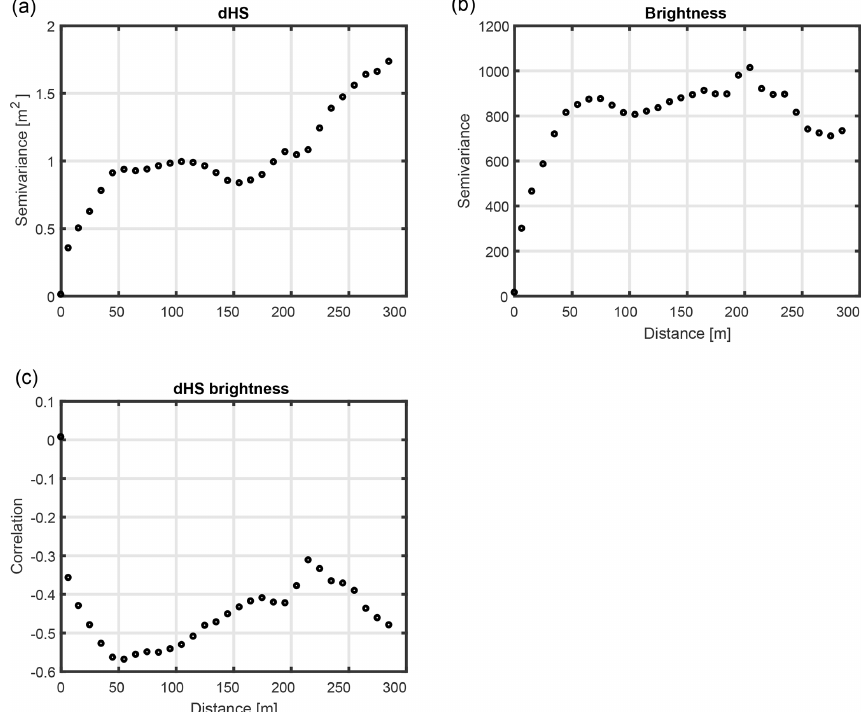
Figure 7. Variograms and correlogram for dHS and brightness.